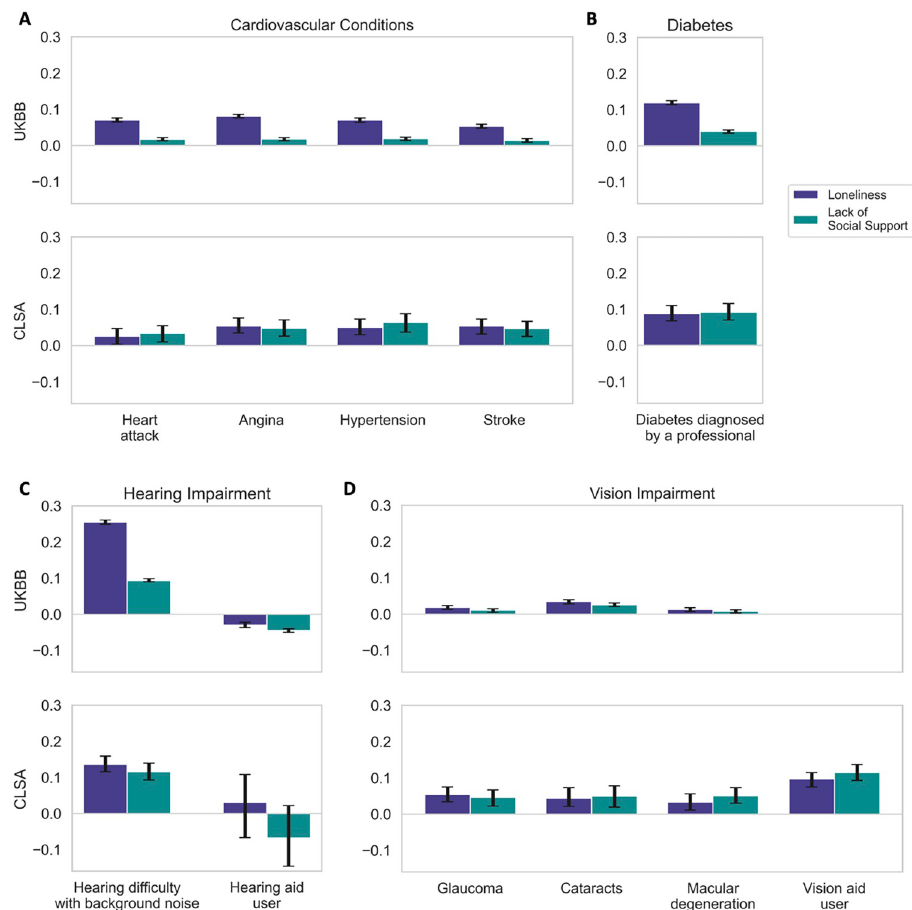
Fig 3. Physical health factors are related to social isolation. Bayesian estimation of the posterior probability that a given risk factor relates to one of two measures of social deprivation: loneliness and lack of social support. All physical health risk factor variables were standardized prior to running the Bayesian models. For simplicity, results are expressed as the mean and the 90% highest posterior density interval of the model coefficients (black error bars). In the UKBB and the CLSA cohorts, loneliness and poor social support show strong links with several physical health factors, such as (A) hypertension, (B) diabetes, (C) hearing difficulty with background noise, and (D) being a vision aid user. Across the two cohorts, hearing difficulty with background noise has the largest association with both subjective and objective social isolation in this pillar of risk traits.